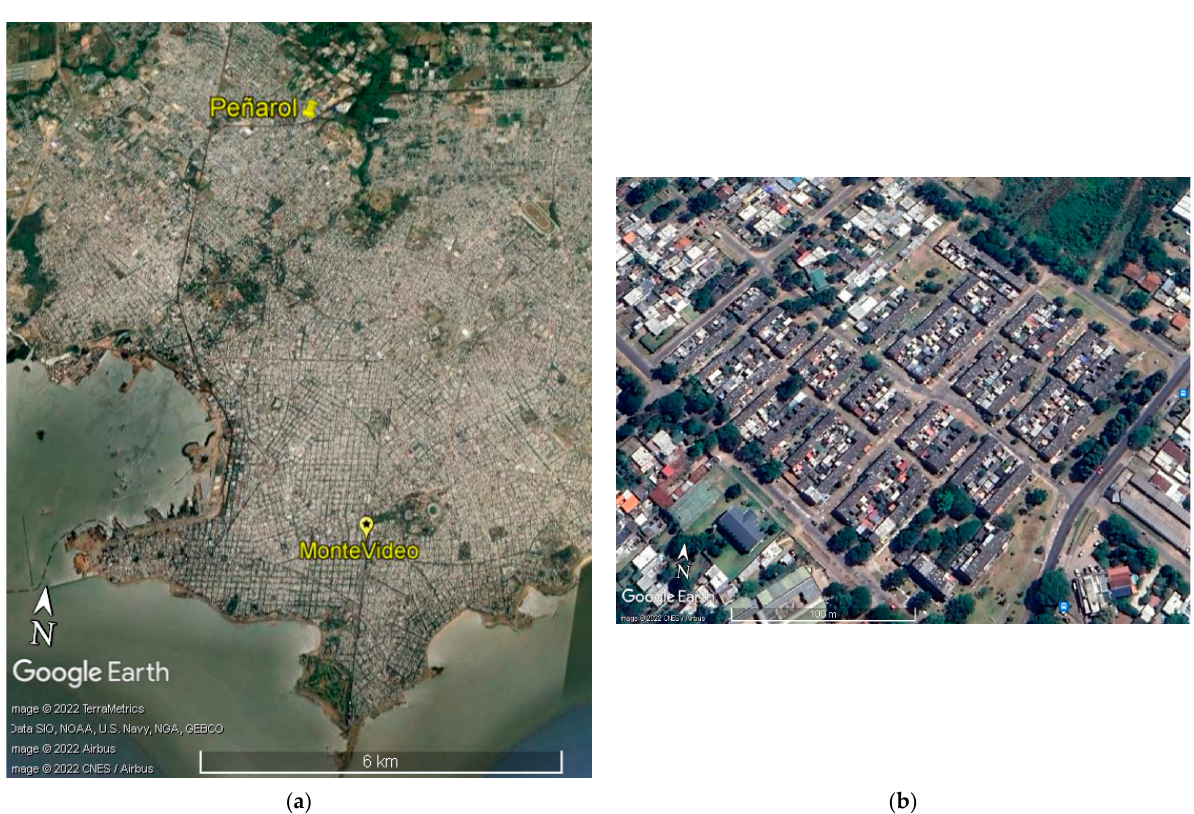
Figure 8. ( a ) Montevideo City with the location of the urban area under study merged in the surroundings of the Peñarol area; ( b ) zoom overused area for the case study.